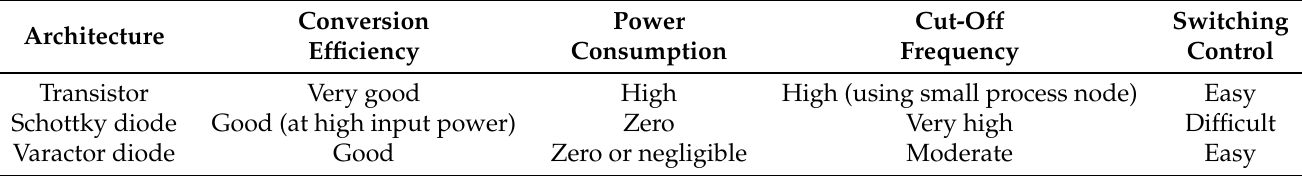
Table 2. Comparison of different harmonic generation techniques.